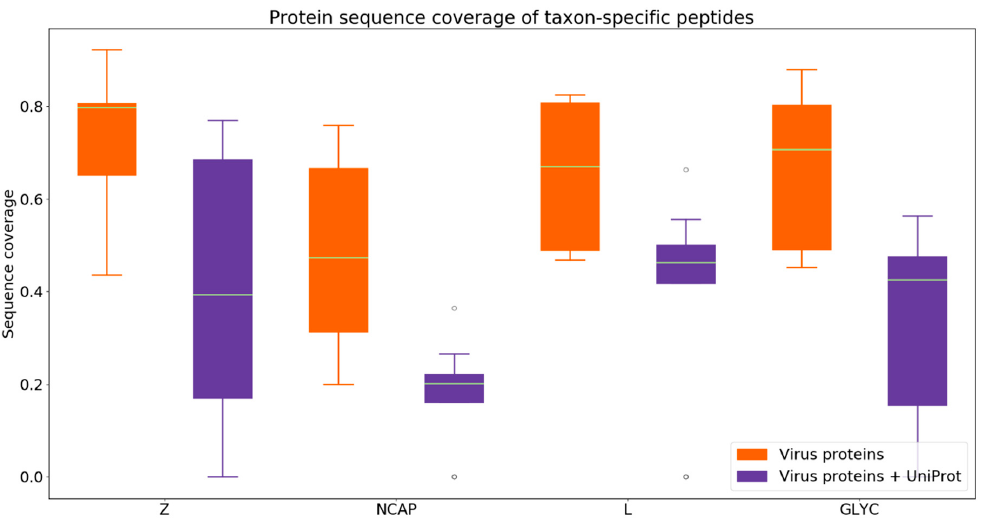
Figure 6. Protein sequence coverage of taxon-specific peptides selected by Purple on proteins for nine arenavirus species proteomes. The four proteins of the arenavirus proteomes are RNA-directed RNA polymerase L (L), nucleoprotein N (NCAP), pre-glycoprotein polyprotein GP complex (GLYC), and RING finger protein Z (Z). The coverage of selected peptides is displayed for homologous matching when applying a background consensus threshold of 80%.